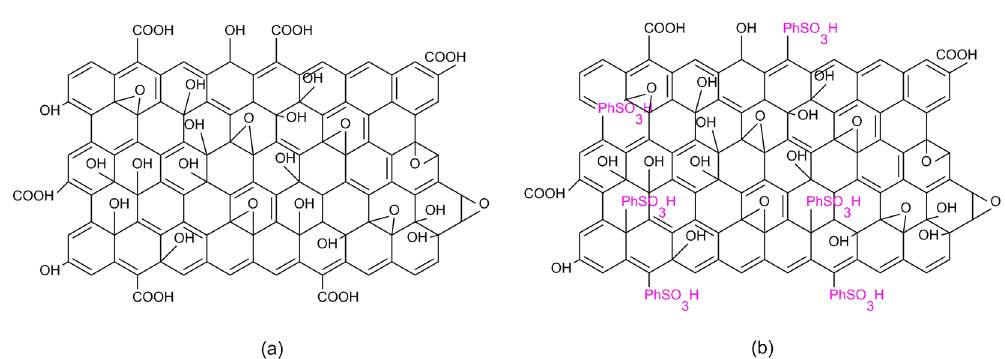
Figure 2. Model structures: ( a ) structural model of graphite oxide (GO) and ( b ) structural model of sulfonated reduced graphene oxide